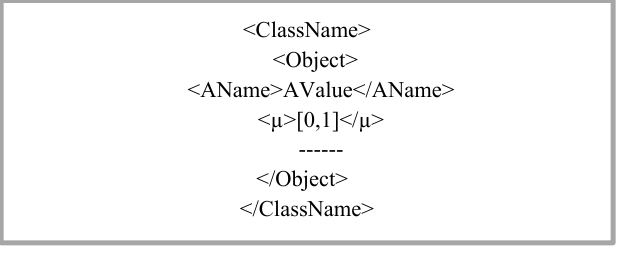
Fig. 2. Insert syntax with XML tags